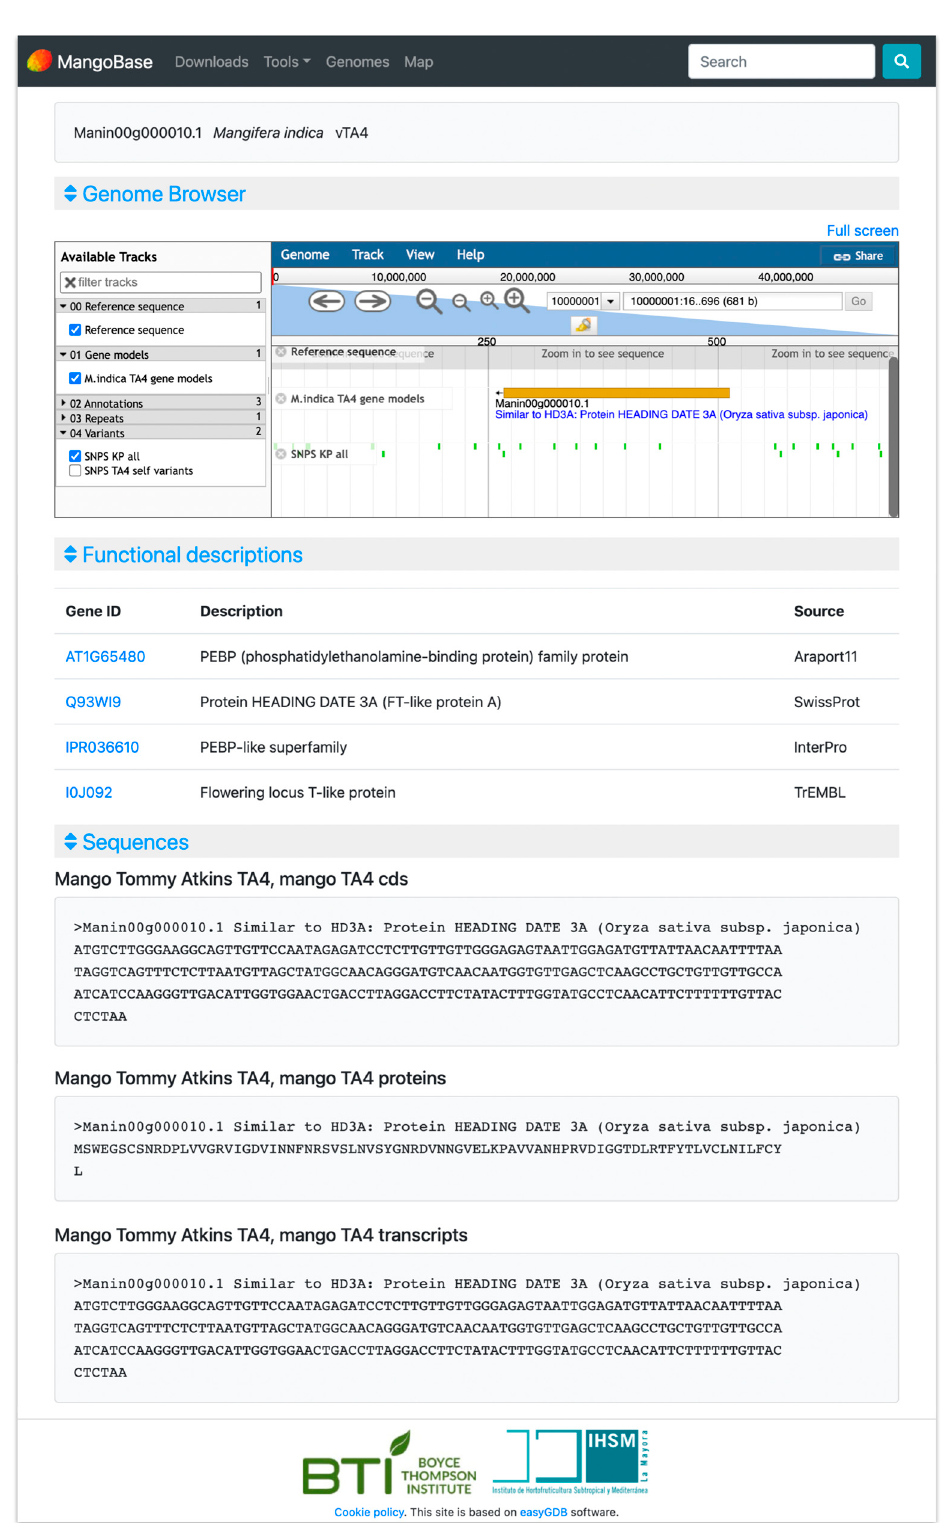
Figure 1. MangoBase gene page example.